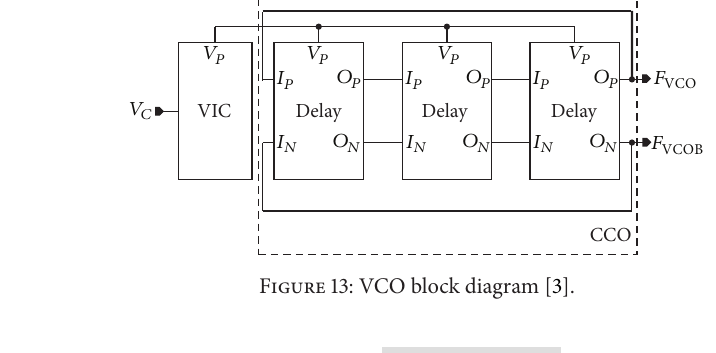
Figure 13: VCO block diagram [3].